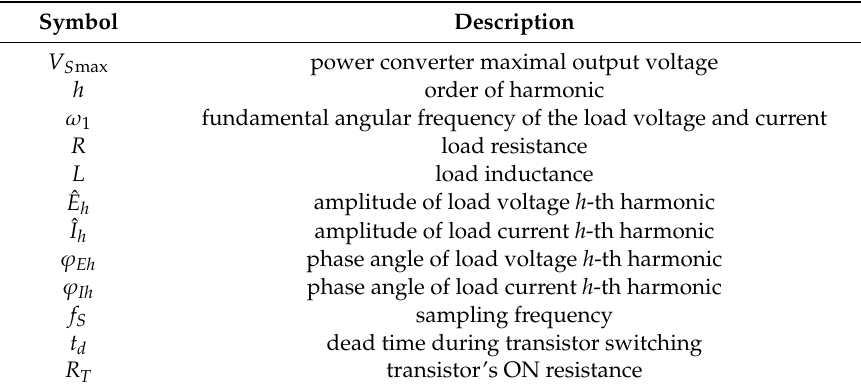
Table 1. System parameters imposing harmonic control